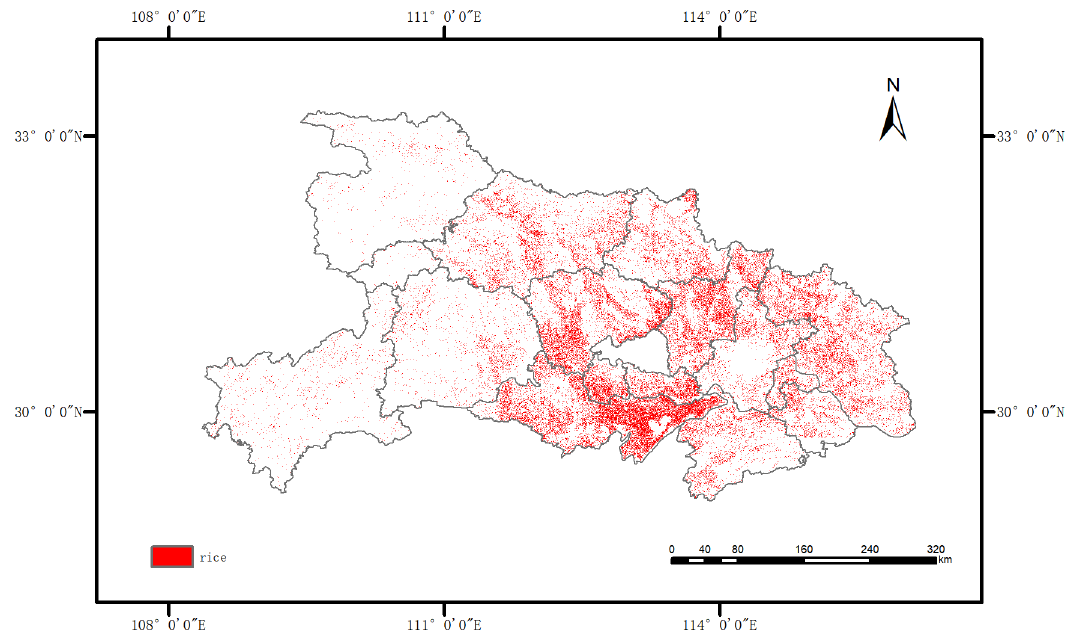
Figure 1. Rice planting area in Hubei